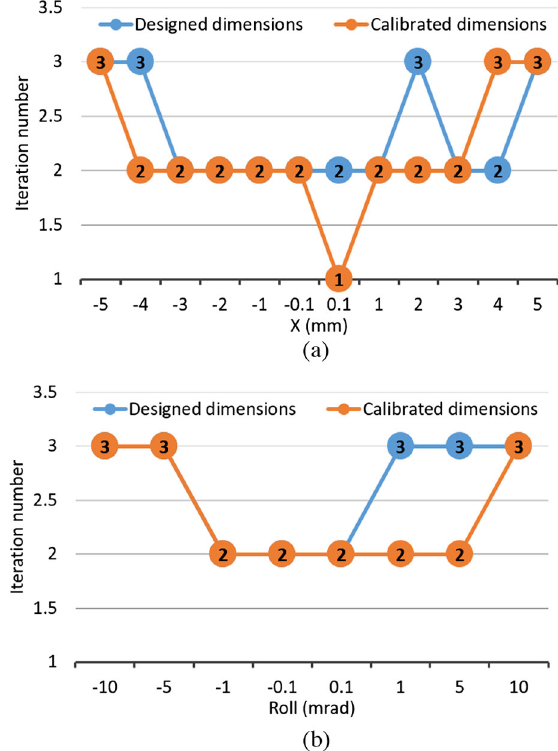
FIG. 15. The comparisons of the interactions: (a) the transition along the X direction and (b) the rotation in the roll